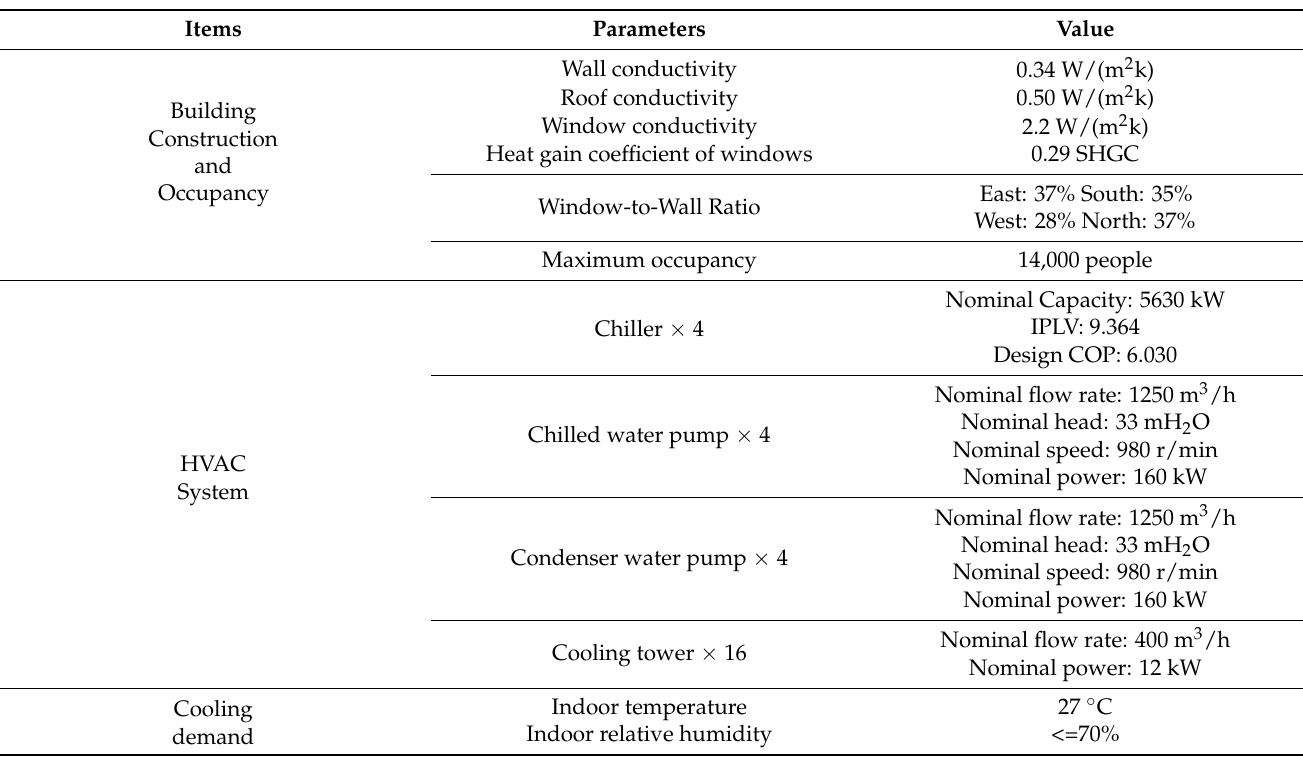
Figure 7. Building layout and EnergyPlus model. Table 1. Detailed information about the study case.